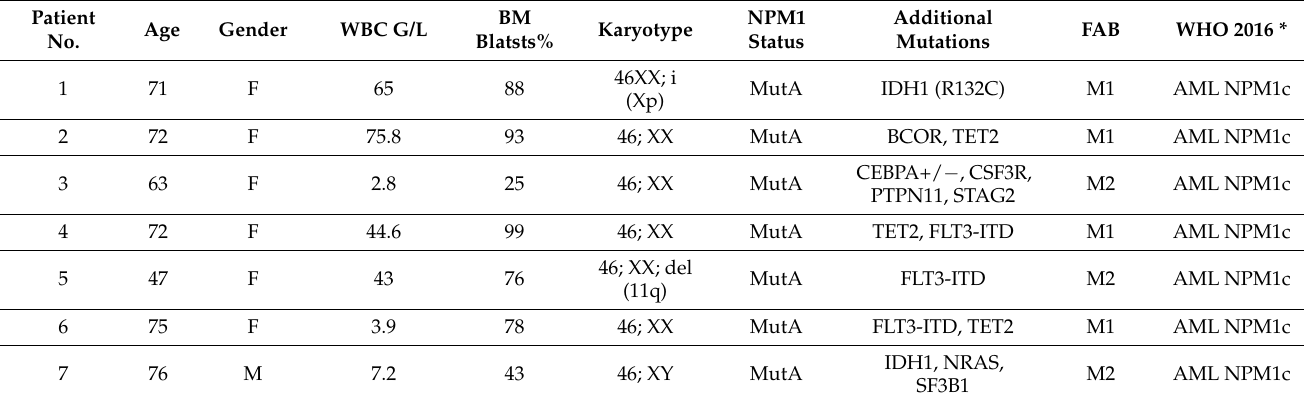
Table 2. Characteristics of patients included in this study (* Provisional